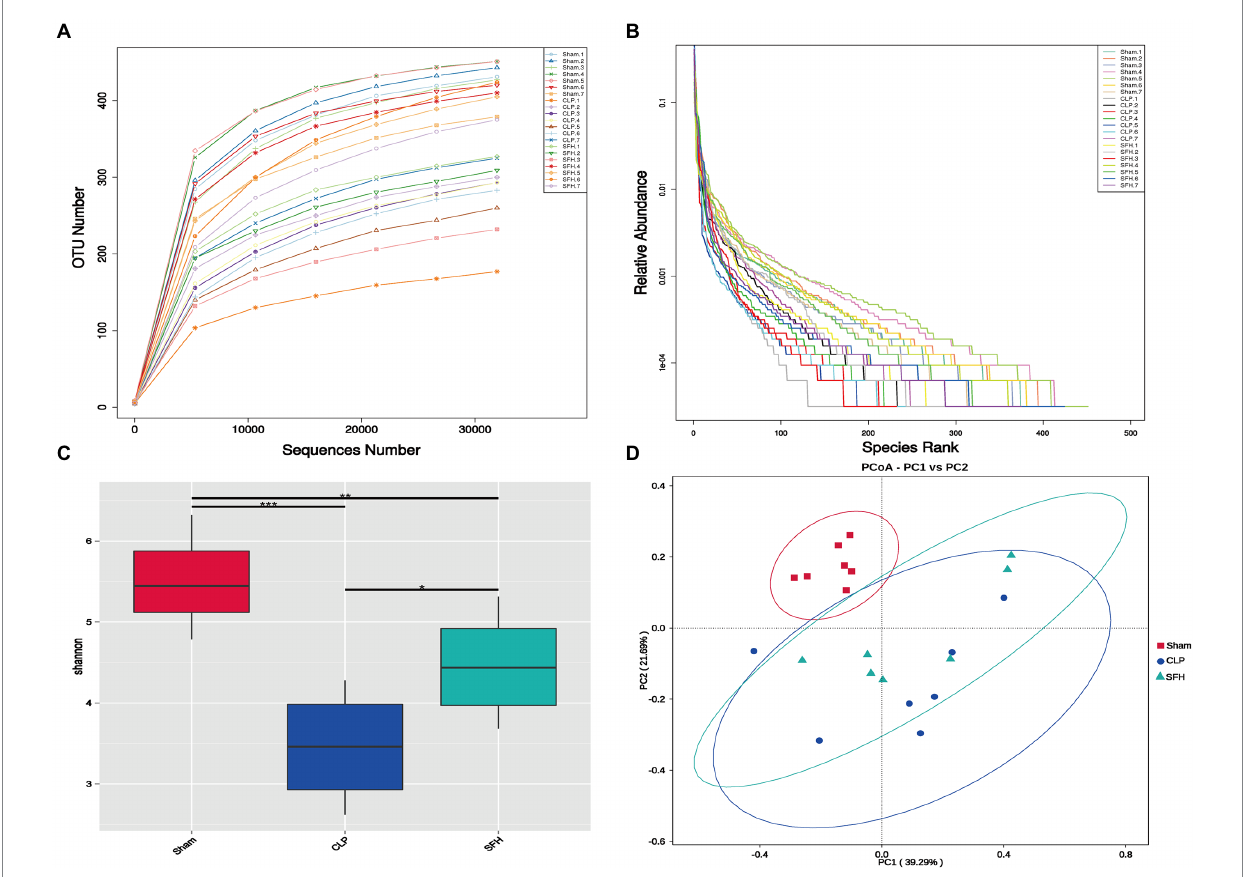
FIGURE 3 SFH treatment affected the gut microbiome diversity in septic mice. (A) Rarefaction curve and (B) rank abundance curve showing the plausibility of the sequencing data and indirectly reflecting species richness in the samples. (C) The Shannon index shows the alpha diversity in each group. (D) PCoA, based on weighted UniFrac distance, shows the beta diversity of each group ( n = 7 per group). Data were presented as means ± SD, * p < 0.05, ** p < 0.01, *** p <